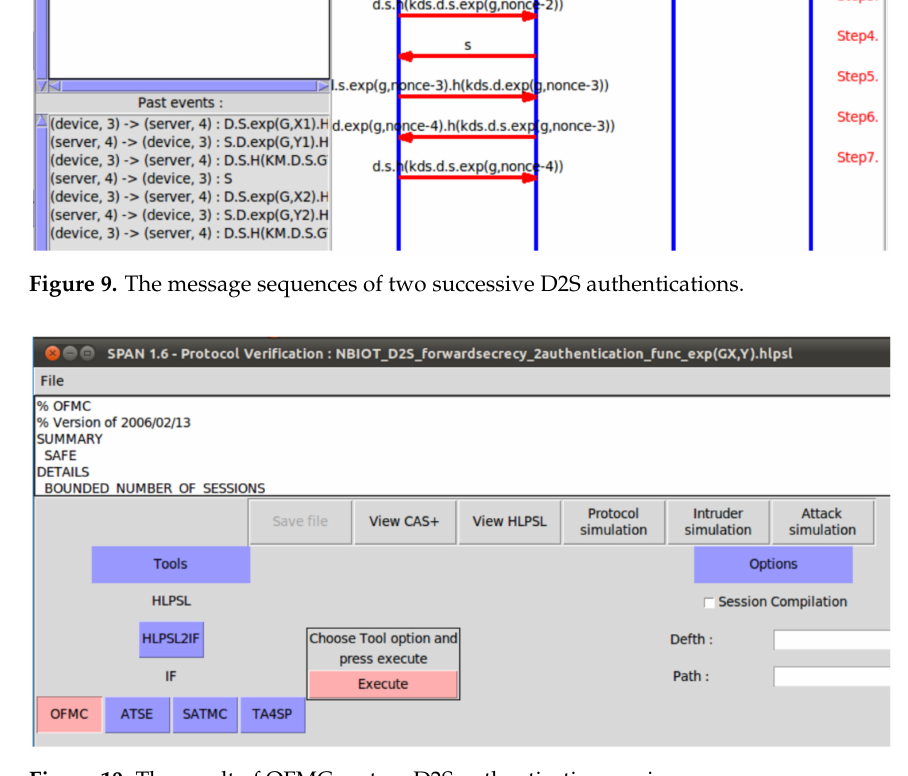
Figure 10. The result of OFMC on two D2S authentication